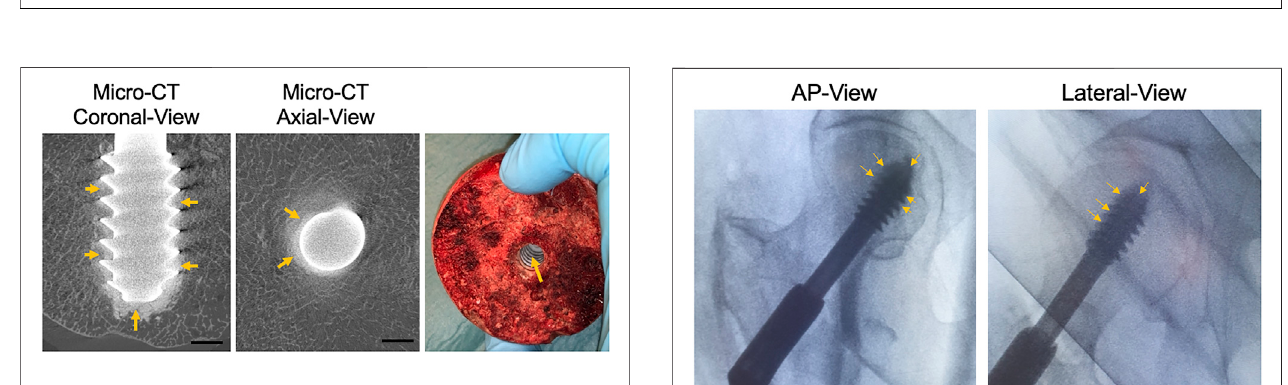
FIGURE5| CaS/HAspreadingaroundthelag-screwandboneinterface in cadaver femoral head as observed by micro-CT and a digital photograph taken after removal of the lag screw. Scale bar indicates ~0.5 cm.